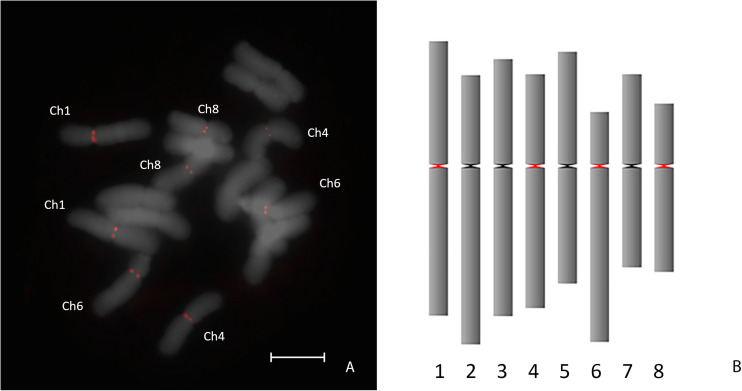
FISH mapping of AfCen1K on A. cepa chromosomes. The chromosomes possessing FISH signals are assigned (A). Ideogram with marked (red) positions of AfCen1K FISH signals (bar = 10 μm) (B).